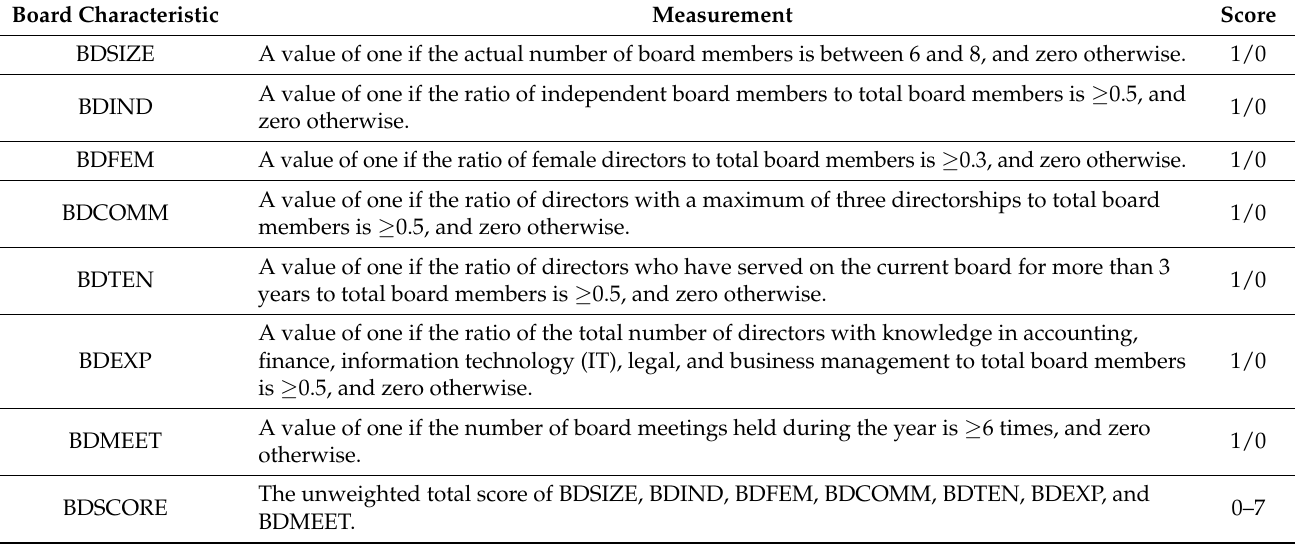
Table 9. Measurement of board score ( BDSCORE ).